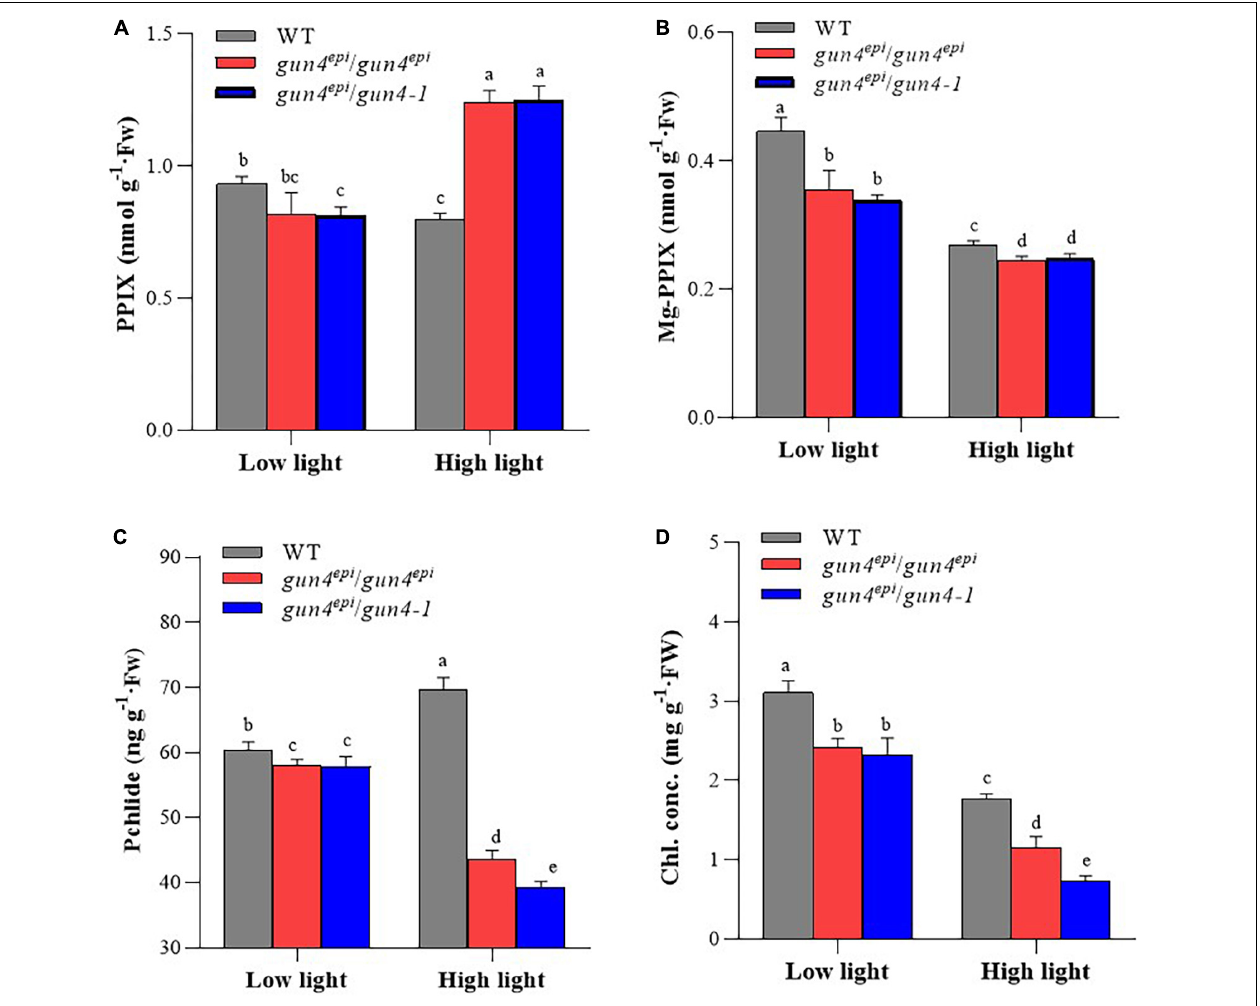
FIGURE 3 | The concentration of tetrapyrrole metabolites in wild-type (WT) and OsGUN4 mutant rice seedlings. Seedlings were at 35 days after germination (DAG) grown under low (100 µ mol m − 2 s − 1 photons) or high (1000 µ mol m − 2 s − 1 photons) light conditions. WT, wild-type variety Longtepu B, gun4 epi / gun4 epi and gun4 epi / gun4-1 are F 2 seedlings derived from the gun4 epi / gun4-1 F 1 plants. PPIX, protoporphyrin IX; Mg-PPIX, Mg-protoporphyrin IX; Pchlide, protochlorophyllide; Chl, chlorophyll. Values are means ± SD ( n = 6) and analyzed for significant differences by two-way ANOVA followed by the Tukey’s multiple comparison test, P < 0.05. For the background information of the F 1 plants, see Supplementary Figure 1